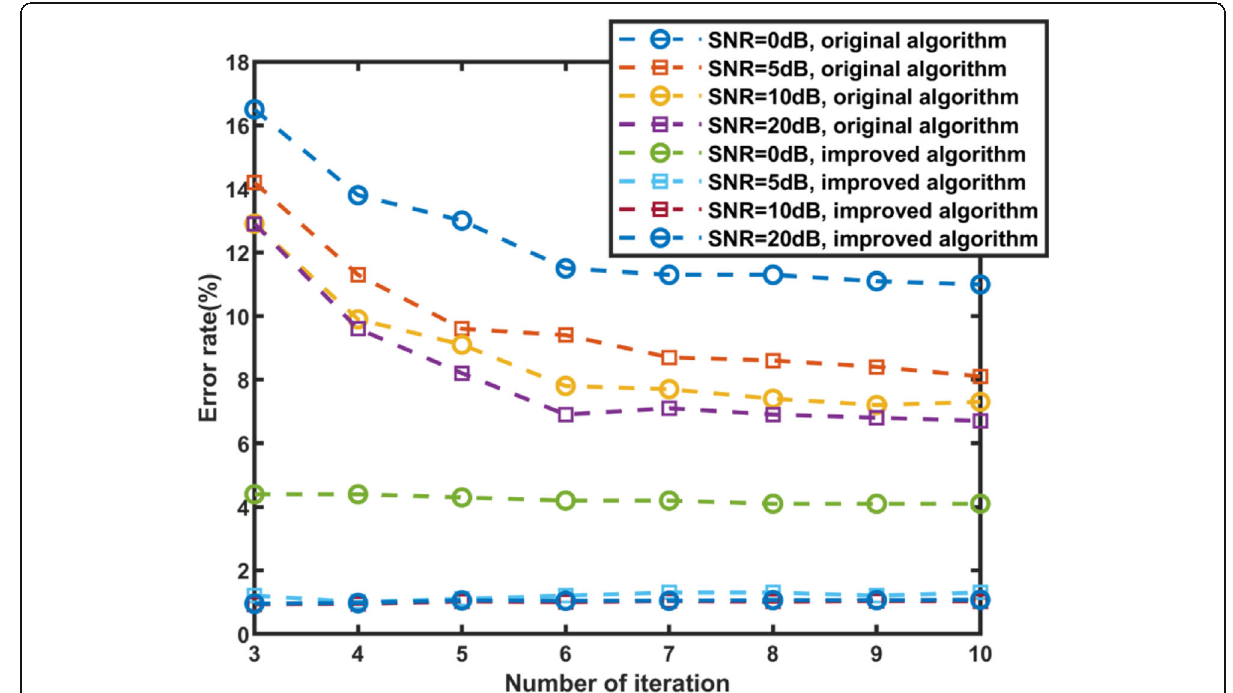
Fig. 5 Error rate under different SNR: the error rate performances of the original algorithm and the processing time and noise resistance- improved algorithm under different SNRs. The x -axis is the number of iterations and the y -axis denotes the error rate. The SNR changes from 0 dB to 20 dB and the step is 5